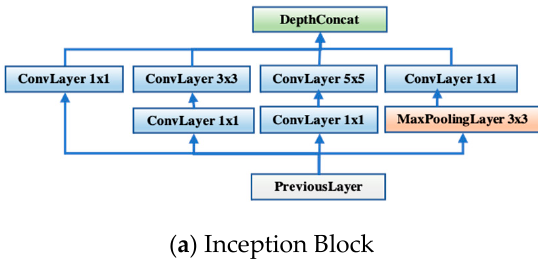
Figure 7. The basic structures of blocks used in GBBNet.